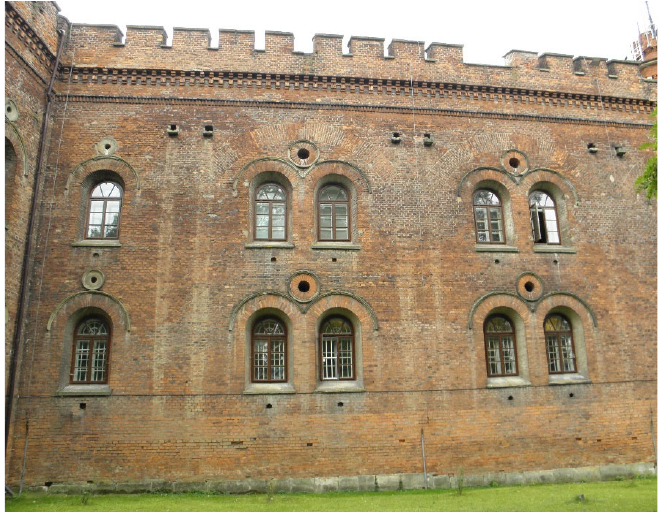
Figure 2. The citadel around the Kosciuszko Mound.